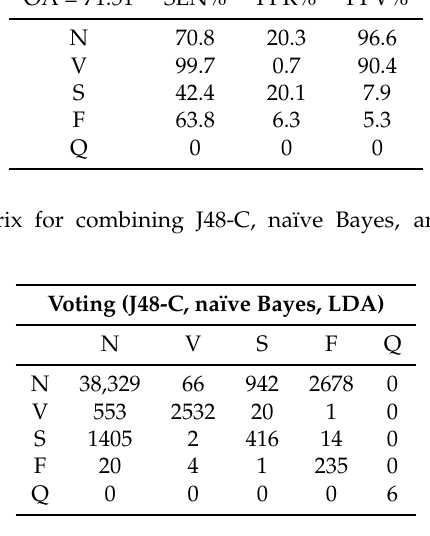
Table 15. Performance measures for combining J48-C, naïve Bayes, and LDA classifiers using a Voting scheme.